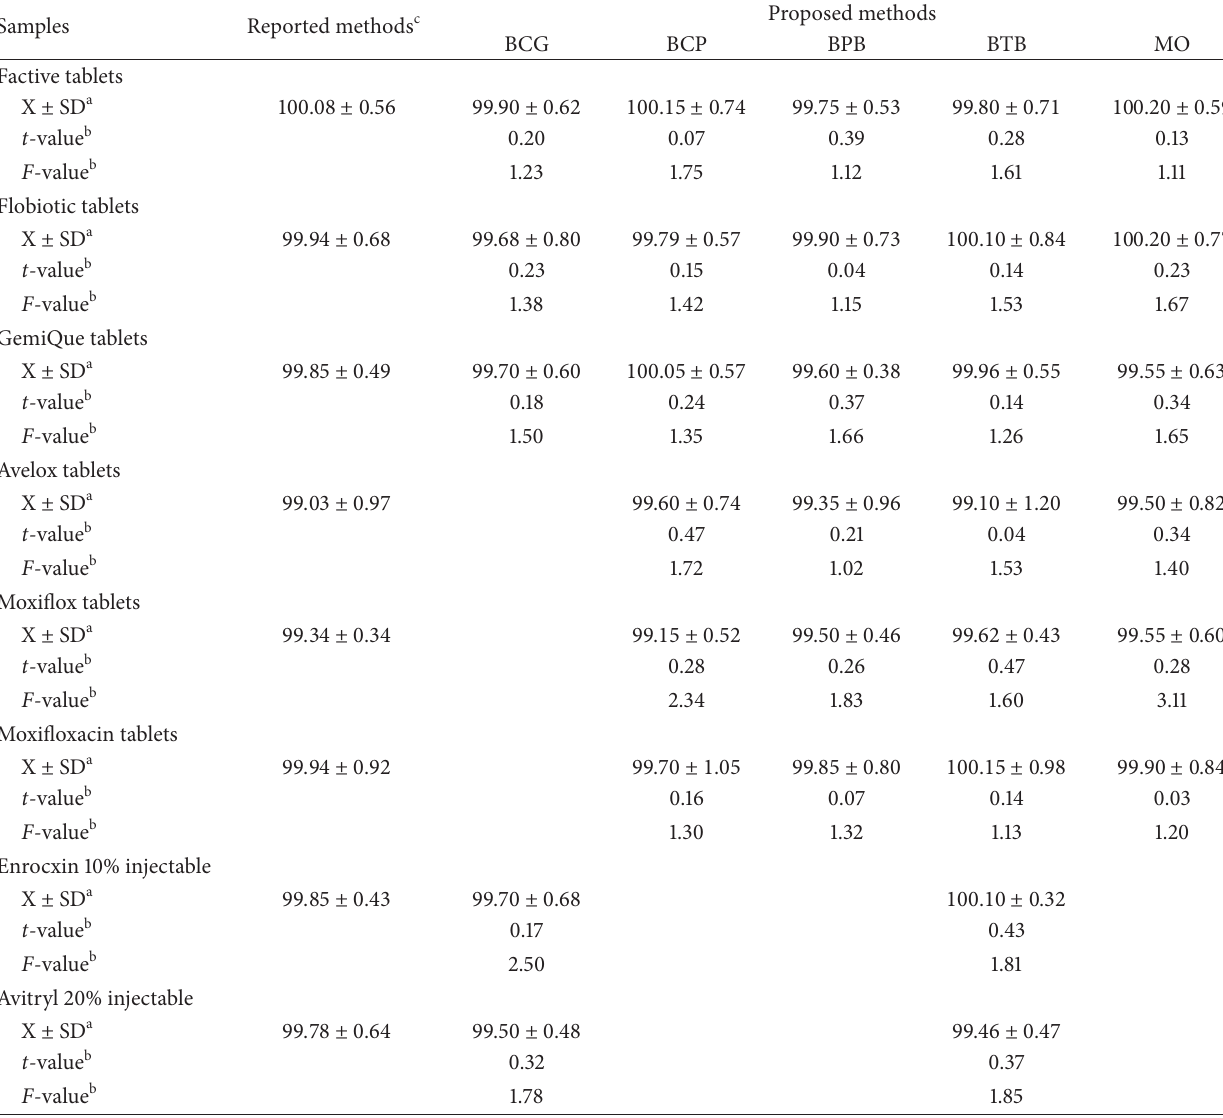
Table 8: Application of the proposed methods for the determination of GMF, MXF, and ENF in their pharmaceutical preparations.